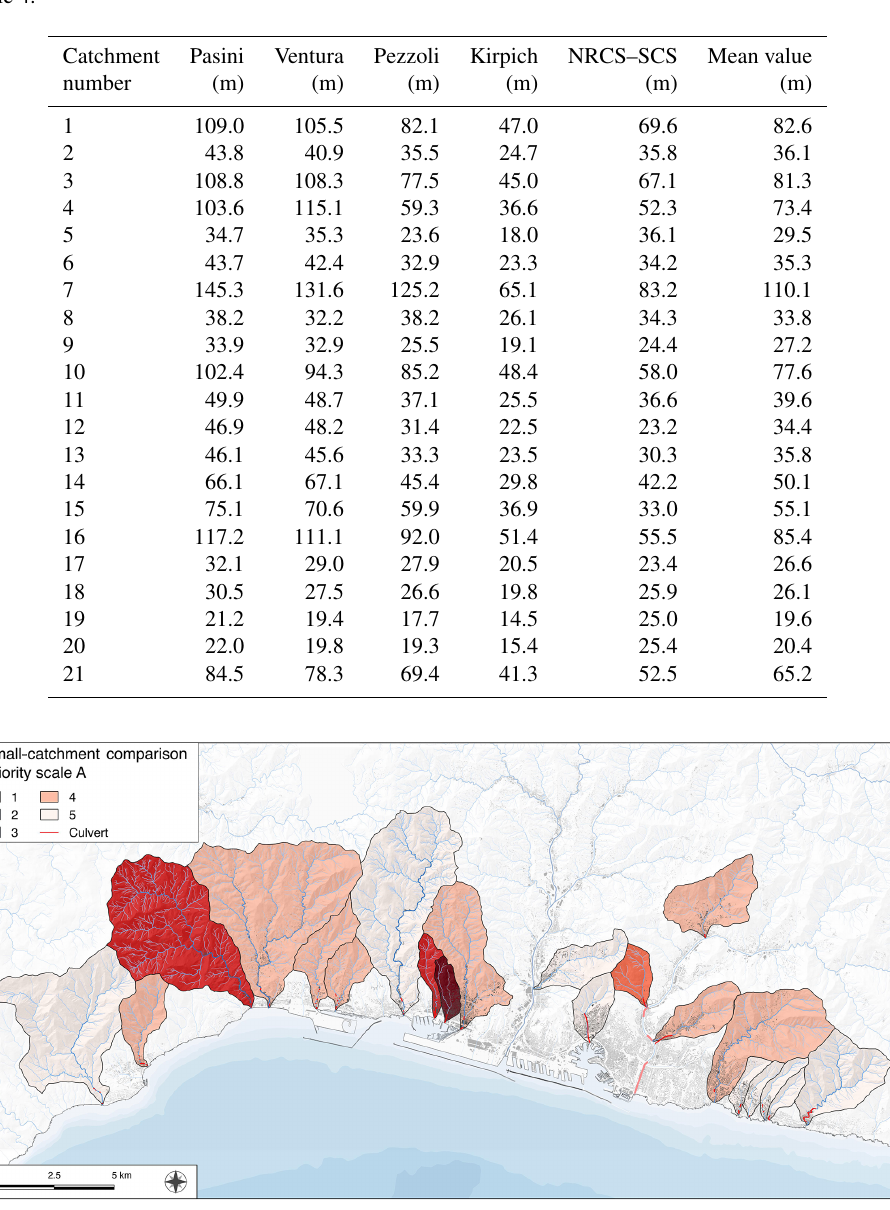
Figure 8. The priority scale obtained using all the parameters, excluding DSGSD for the calculation of landslides.